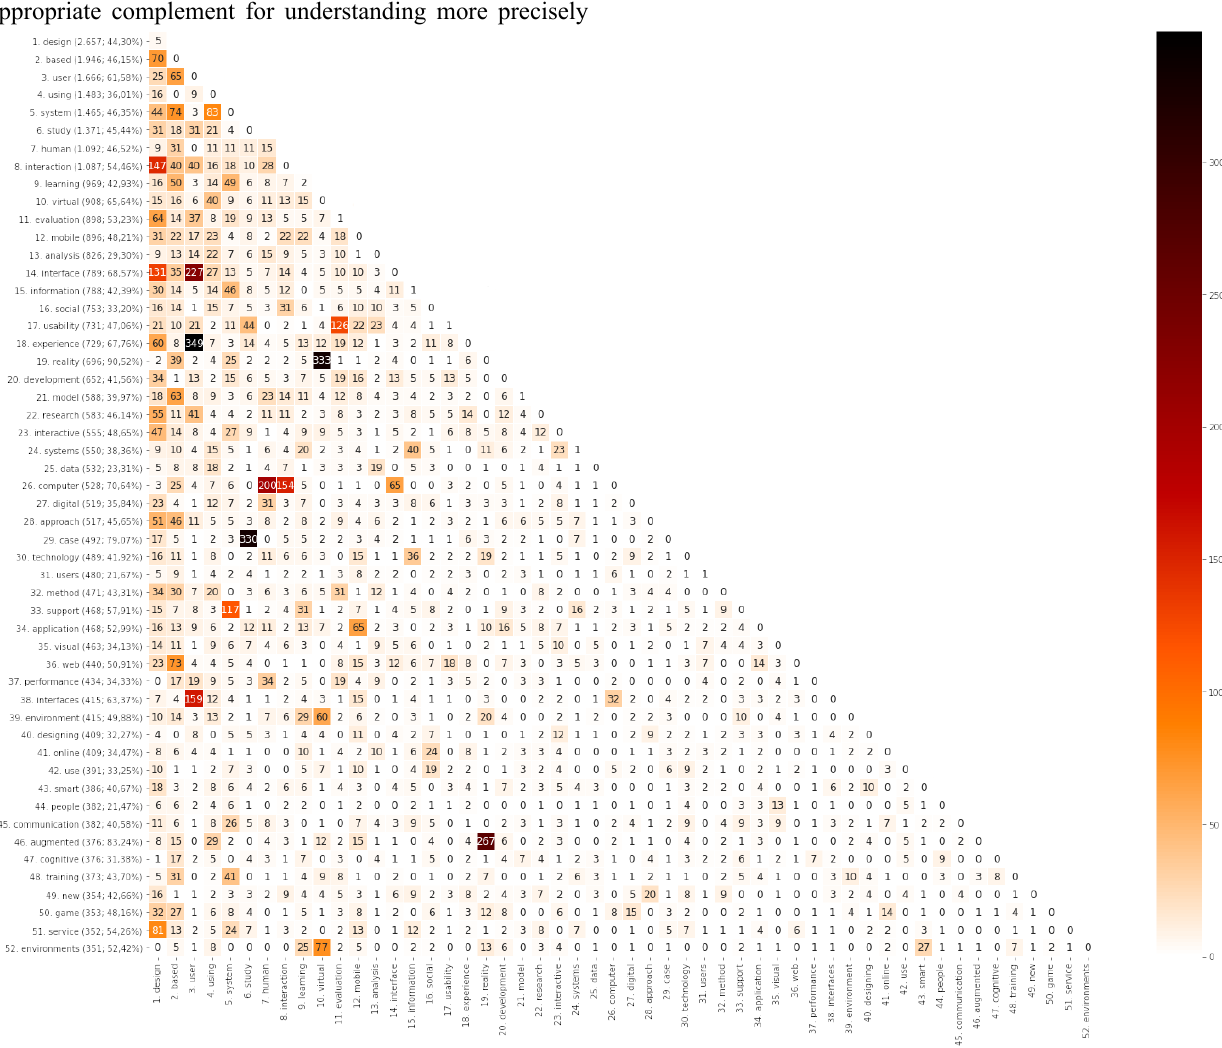
Figure 2. Correlation matrix of the n1 (52) most recurring words from